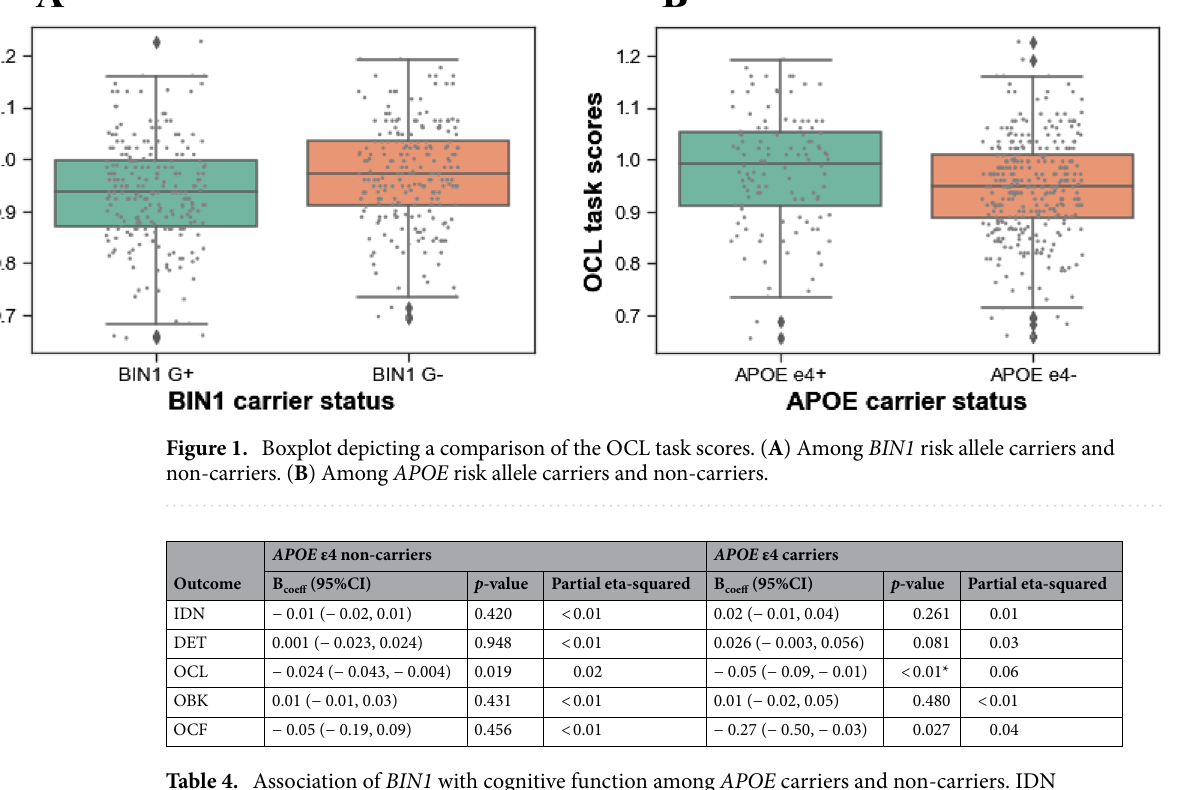
Table 4. Association of BIN1 with cognitive function among APOE carriers and non-carriers. IDN (identification) task measures visual identification/attention, DET (detection) task measures psychomotor function, OCL (one-card learning) task measures recognition memory/learning, OBK (one-back) task measures working memory and OCF refers to the overall cognitive function. *Significant after false discovery rate (Benjamini–Hochberg)